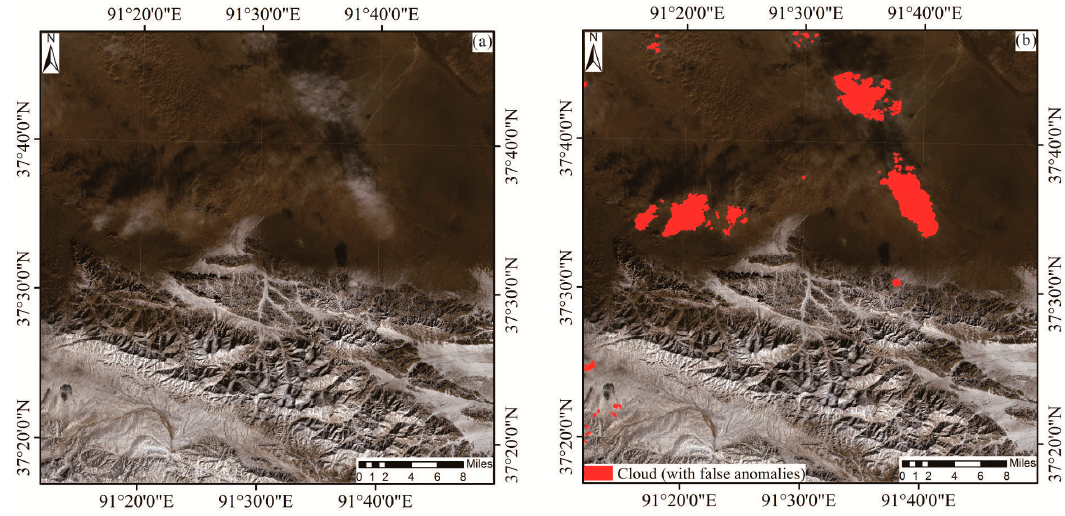
Figure 8. Output image of cloud detection. Red colored areas represent clouds; a 100 m one-sided buffer zone around patches of thick cloud could include thinner clouds that were not detected previously. ( a ) Original image; ( b ) final cloud detection result.